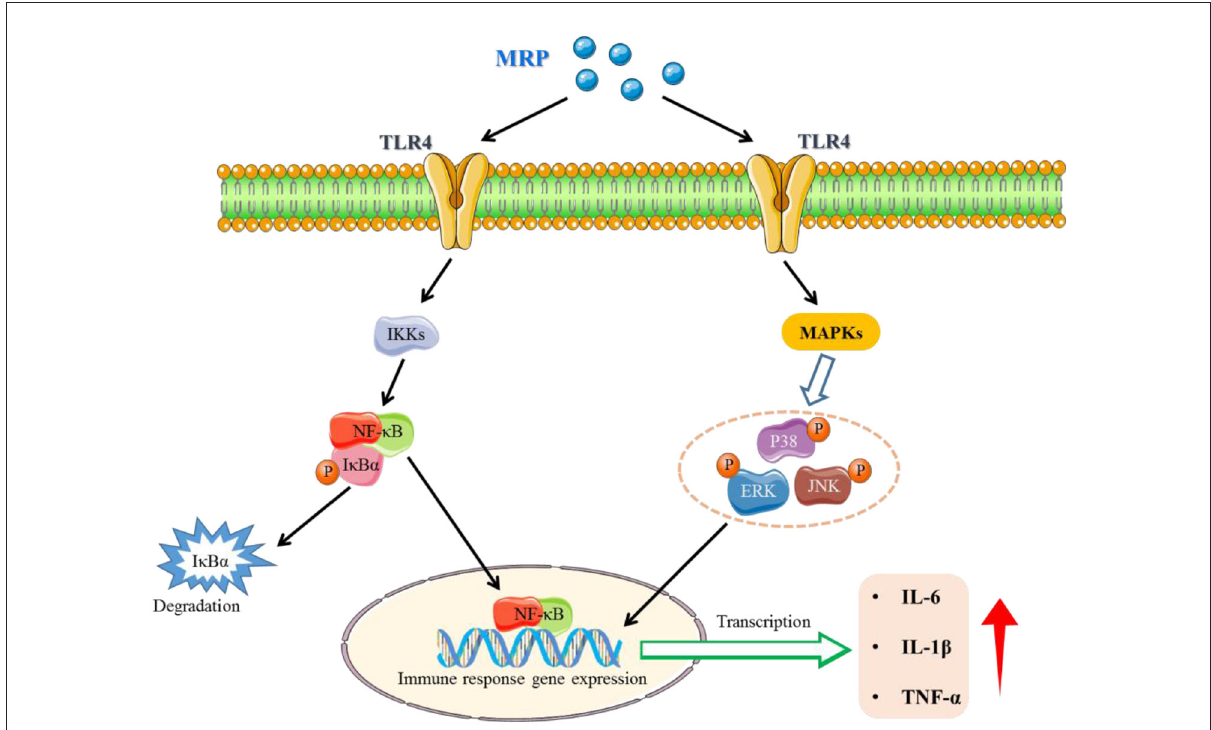
FIGURE8 A potential signaling pathway involved in the immune-enhancement of CTX-induced immunosuppressed